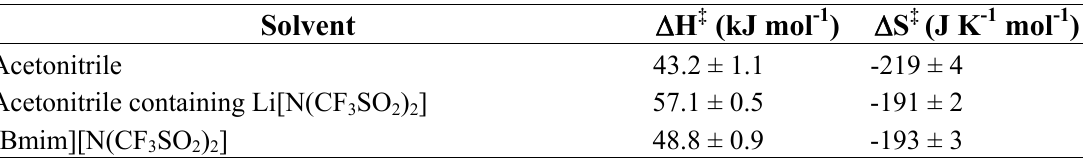
Table 1. Activation parameters for the reaction outlined in Scheme 2 in the solvent system specified. Uncertainties quoted are standard